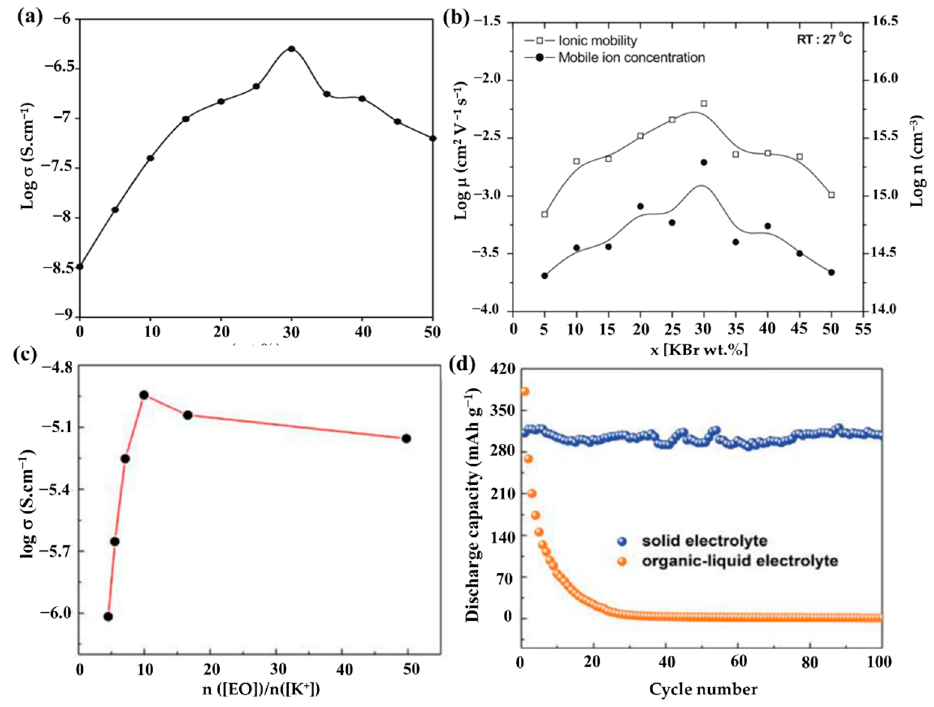
Figure 7. ( a ) “Log σ -x” plot for the hot-pressed SPEs: (1-x) PEO: x KBr, where x in wt%. ( b ) “Log µ -x” and “log n-x” plots for the hot-pressed SPEs: (1-x) PEO:x KBr. ( a , b ) Reproduced with permission from Ref. [86]. Copyright 2022 IACS. ( c ) Ionic conductivity of the PEO-KFSI SPE with varied molar ratio of [EO]/[K + ] at 40 ◦ C. ( d ) Comparison of cycling performance using 3 h Ni 3 S 2 @Ni electrode between PEO-based SPE and the organic–liquid electrolyte at a current density of 25 mAh/g. ( c , d ) Reproduced with permission from Ref. [75]. Copyright 2019 Elsevier B.V.